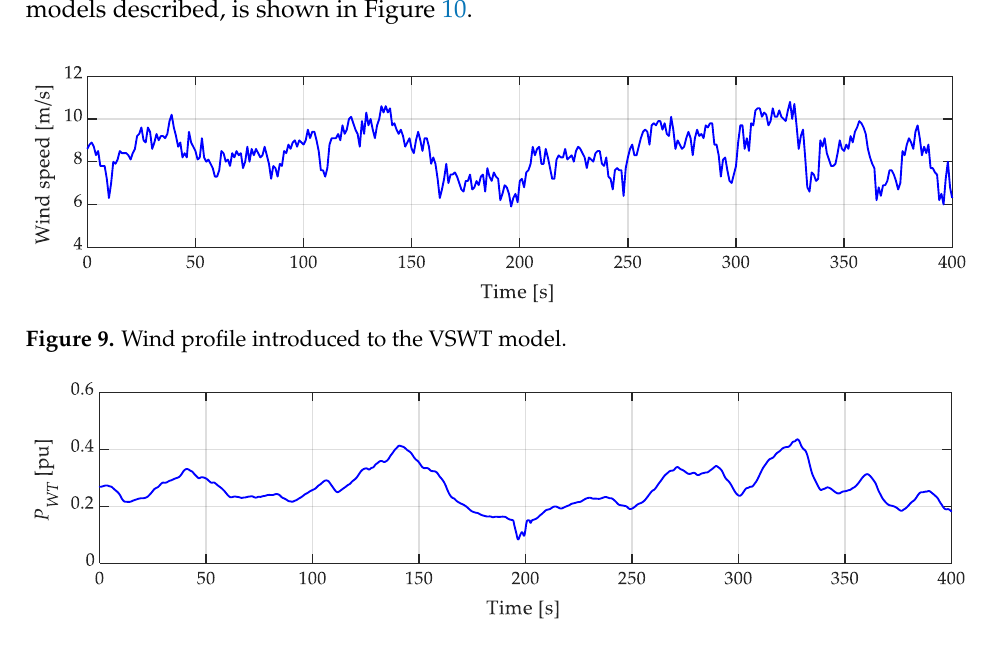
Figure 12. Power set-point generated by the algorithm that serves as the command for the SC – ESS to smooth the wind power. Finally, it is evident in Figure 13 that the power injected to the system, P T , is smoothed compared to the one with no smoothing. Then, the power fluctuations are flattened by reducing the power peaks and displacing them in certain cases; this effect depends on the state of charge of the SC and the decision of the controller. It is important to note that the proposed control system avoids peaks and valleys in the power curve. Figure 13. Wind power generated by the VSWT and the expected resulting power with the applica- tion of the proposed algorithm.